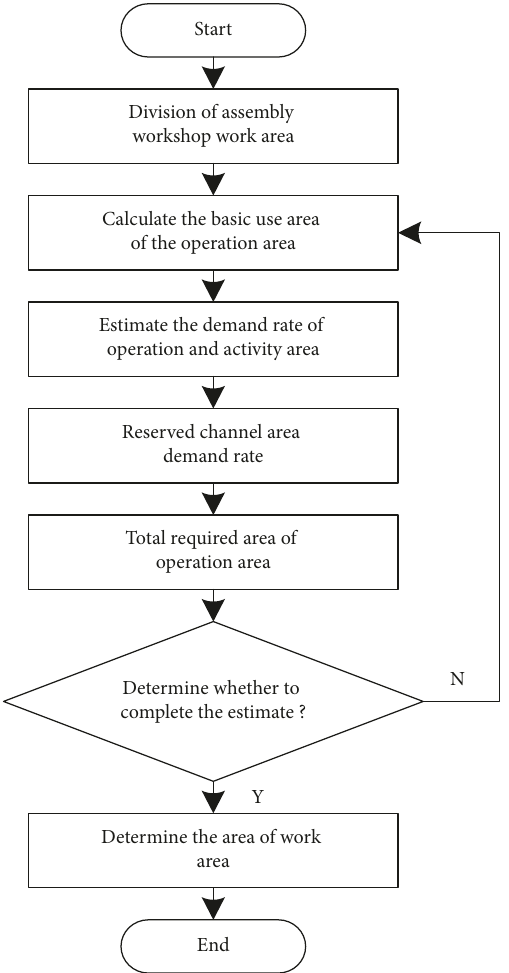
Figure 4: Flow chart for determining the area of the workshop facility operation buffer